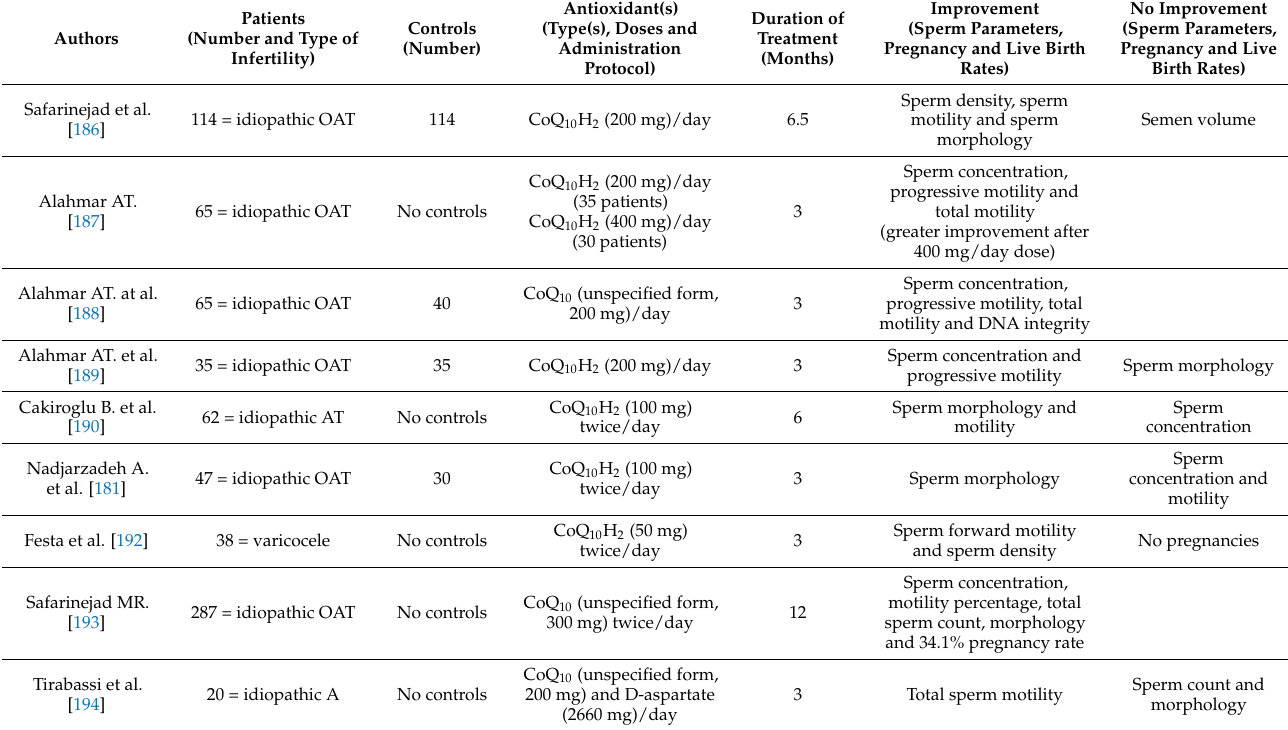
Table 4. Summary of the main results obtained in the 9 papers focusing on the effect of CoQ 10 administration for the treatment of male